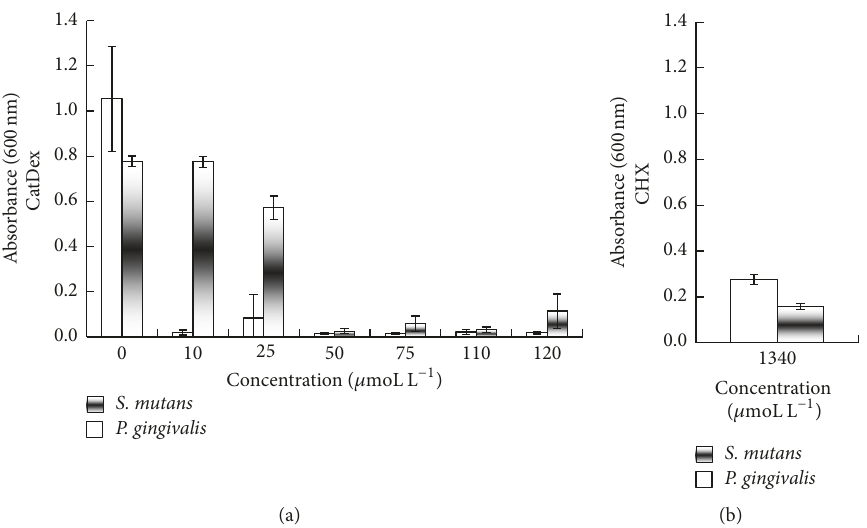
Figure 3: Determination of the minimum inhibitory concentration (MIC) of CatDex (a) and CHX (b) against S. mutans UA130 and P. gingivalis W83 ( 𝑝 ≤ 0.05 ). At all concentrations, CatDex showed a significant impact on S. mutans , and P. gingivalis growth also demonstrated a similar effect except at 25 𝜇 moL L −1 , both compared to CHX 1340 𝜇 moLL −1 ( 𝑝 < 0.05 ).